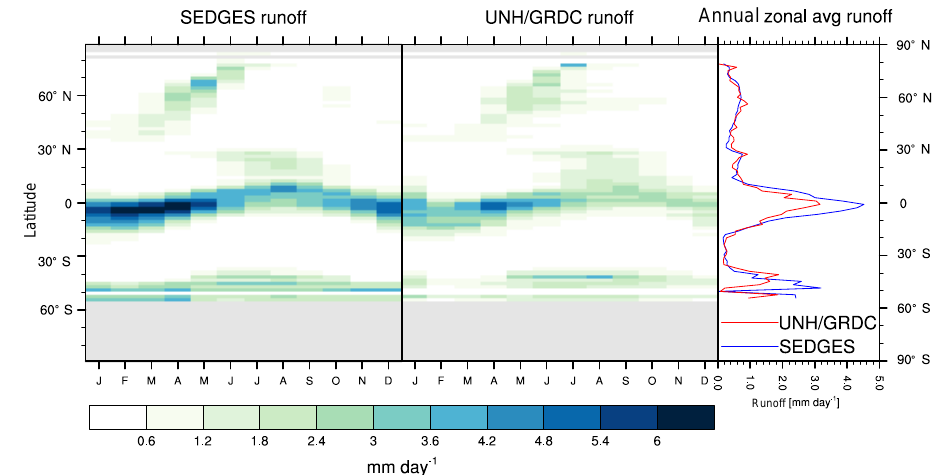
Figure 17. Zonal monthly mean and zonal annual mean climatologies of runoff for SEDGES and the UNH-GRDC reference dataset (Fekete et al., 2002) over non-glaciated